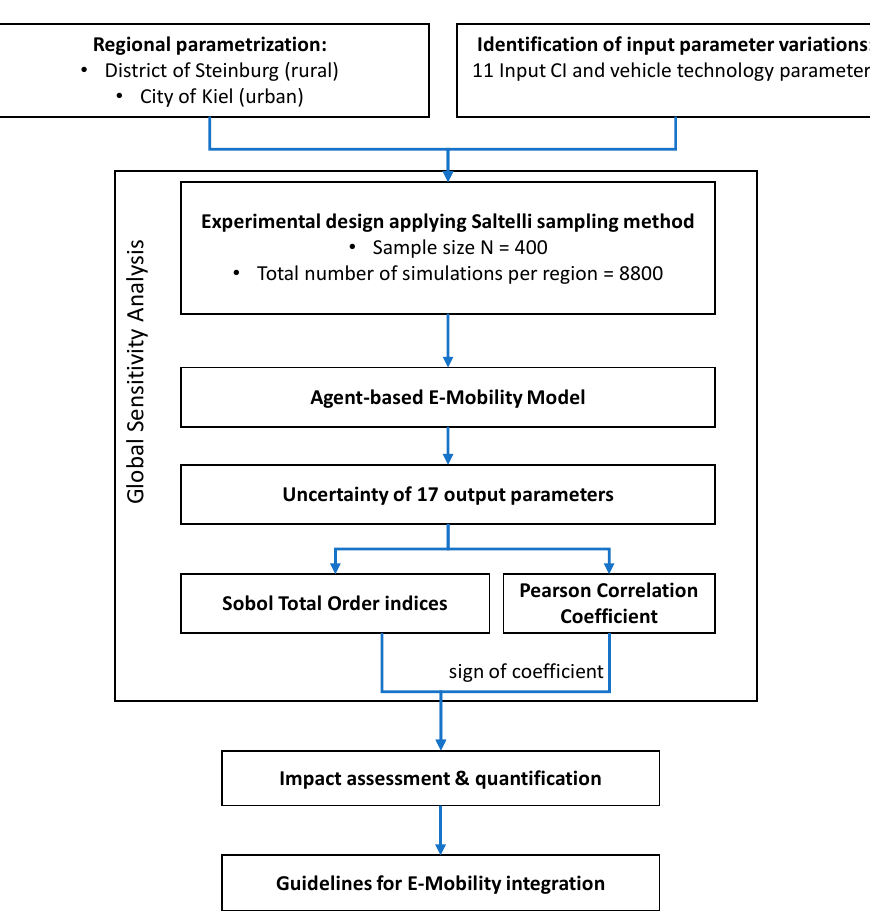
Figure 3. Impact assessment procedure.